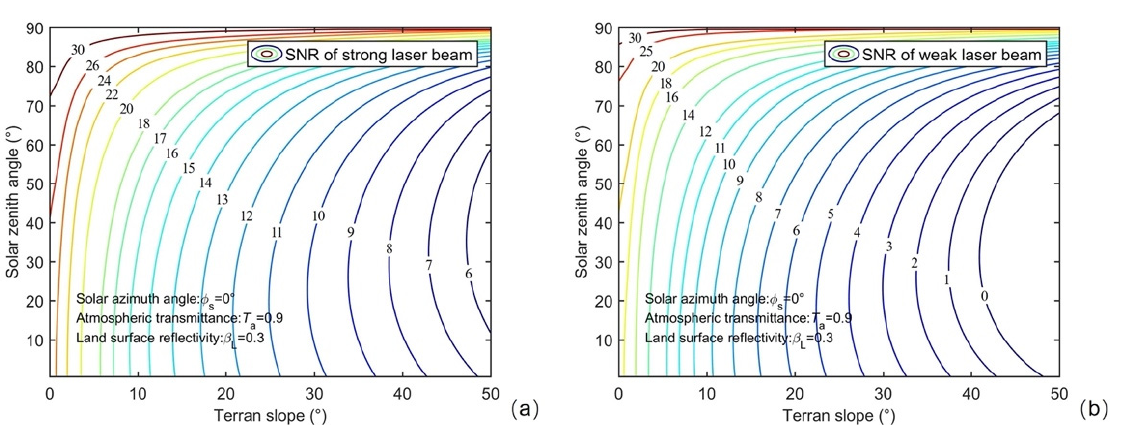
Figure 3. Theoretical signal–noise ratio (SNR) contours for the ICESat-2 strong and weak beams under different environ- mental conditions. ( a ) SNR corresponding to the strong laser beam, and ( b ) SNR corresponding to the weak laser beam. The solar spectral irradiance was set as 1.83 W/m 2 · nm at the wavelength of 532 nm in calculation. The values of σ h and Var( ξ ) were both set as 0 because they had relatively weaker impacts on SNRs than the surface slopes and solar zenith angles.